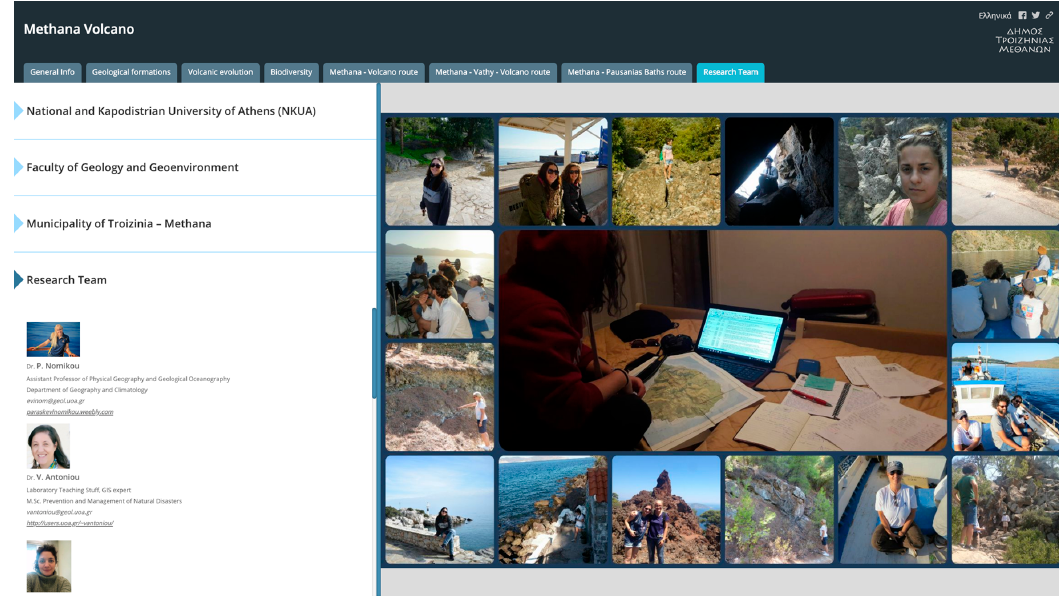
Figure 16. Screenshot of the last tab, where narrative text, multimedia context and external links are used to effectively visualize the information concerning the Research Team (https://goo.gl/Kk6xqD).